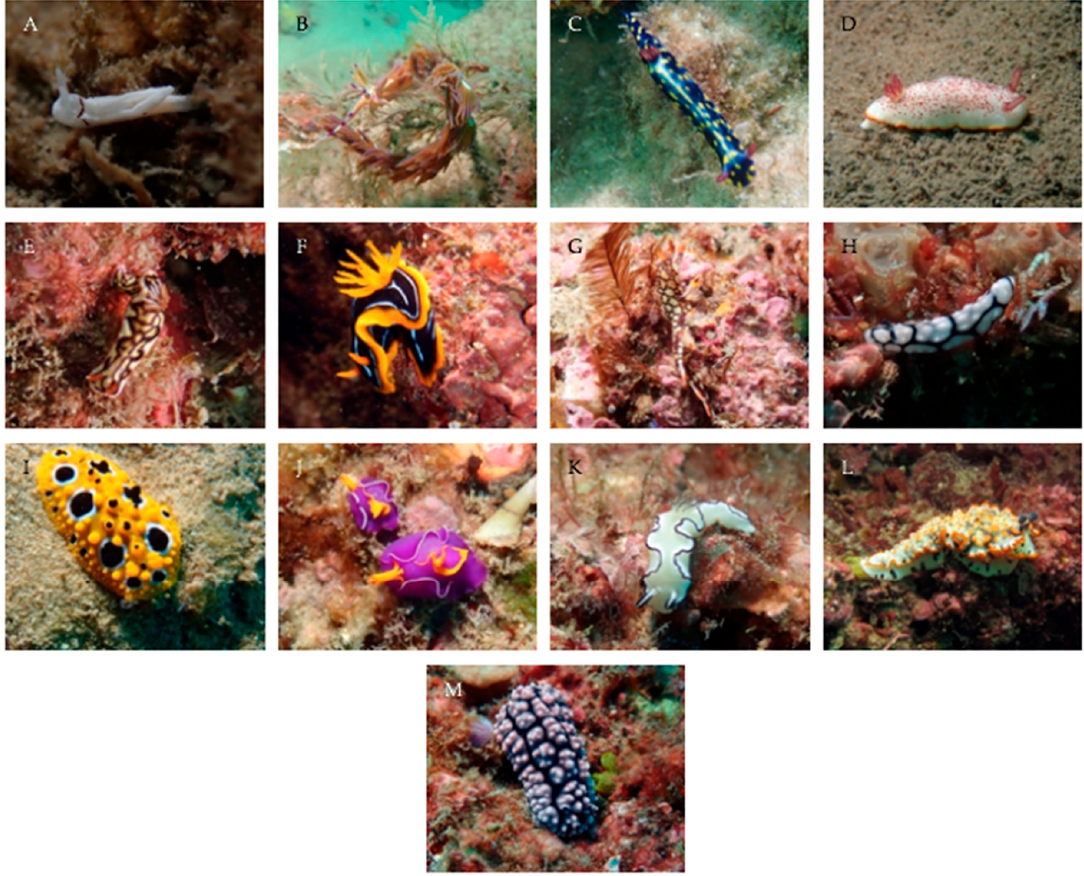
Figure 4. Images of the most frequently observed species in surveys at both sites. ( A )— Goniodoridella